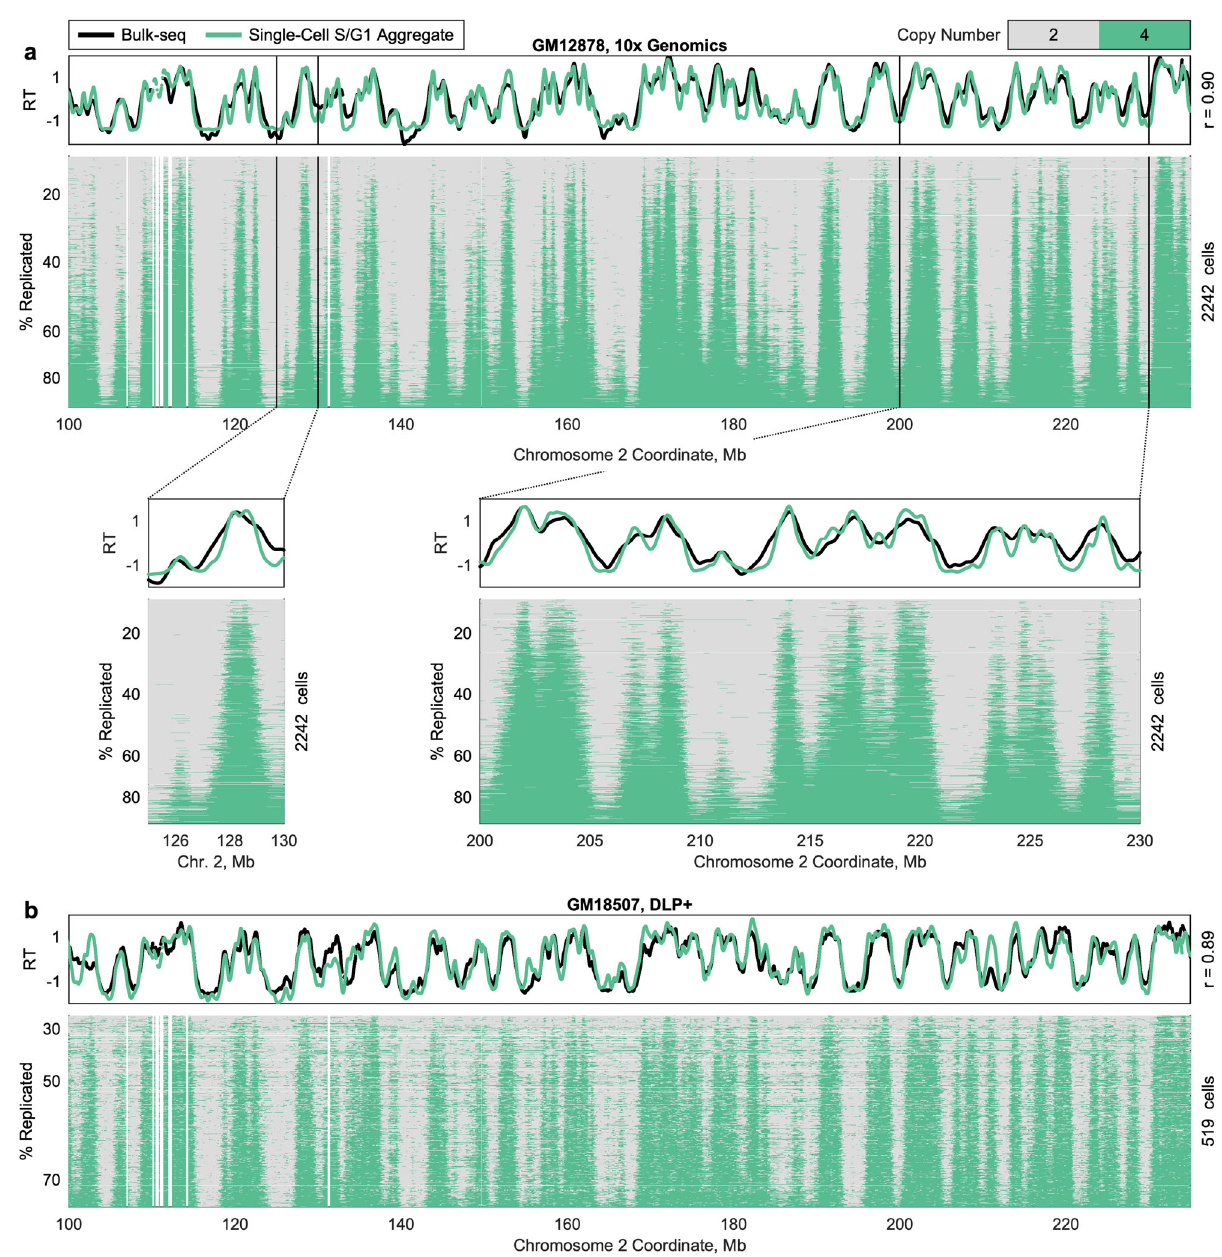
Fig. 2 Single-cell replication-state data, generated by multiple library preparation protocols. a Single-cell replication pro fi les for 2242 GM12878 cells (including both sorted and unsorted cells), following single-cell isolation and library preparation with the 10x Genomics Single-Cell CNV Solution. Consistency of the replication program is observed across cells at chromosome scale and at the level of individual peaks (inset). Pileups re fl ect sharply de fi ned and consistently replicated regions, which overlap peaks in the bulk replication-timing pro fi le. Variation in activation time during S phase among initiation sites is also observed to mirror the replication-timing pro fi le. Each row represents a single cell, sorted by the percent of the genome replicated, and each column represents a fi xed-size window of 20 kb. In total, 195 cells are not shown due to copy-number aberrations on this chromosome. Low- mappability regions and cell-speci fi c copy-number alterations have been masked (white). Insets show smaller regions. b Single-cell replication pro fi les for 519 GM18507 cells, following ampli fi cation-free direct DNA transposition single-cell library preparation (DLP + ). Due to noise, only 480 – 614 of the 759 S-phase cells were analyzed for any given chromosome. Raw data are from 18